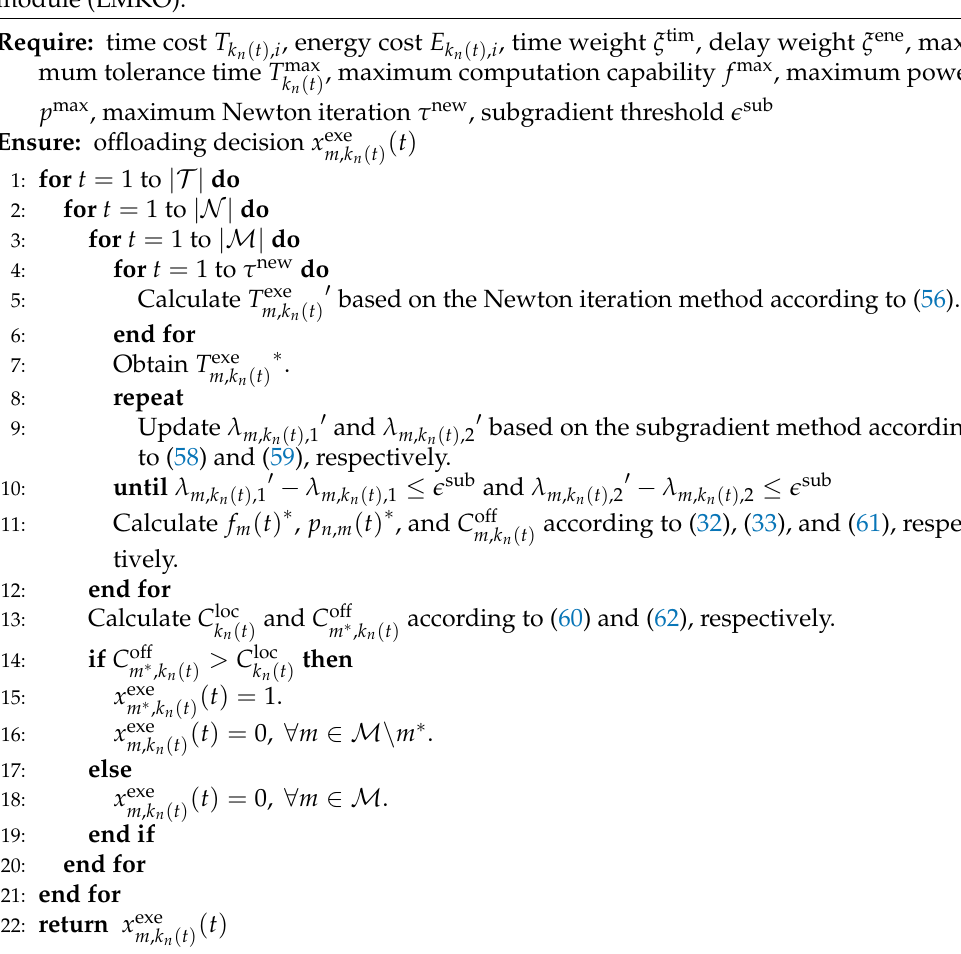
Algorithm 1 Method of Lagrange multipliers with the KKT condition-based offloading module